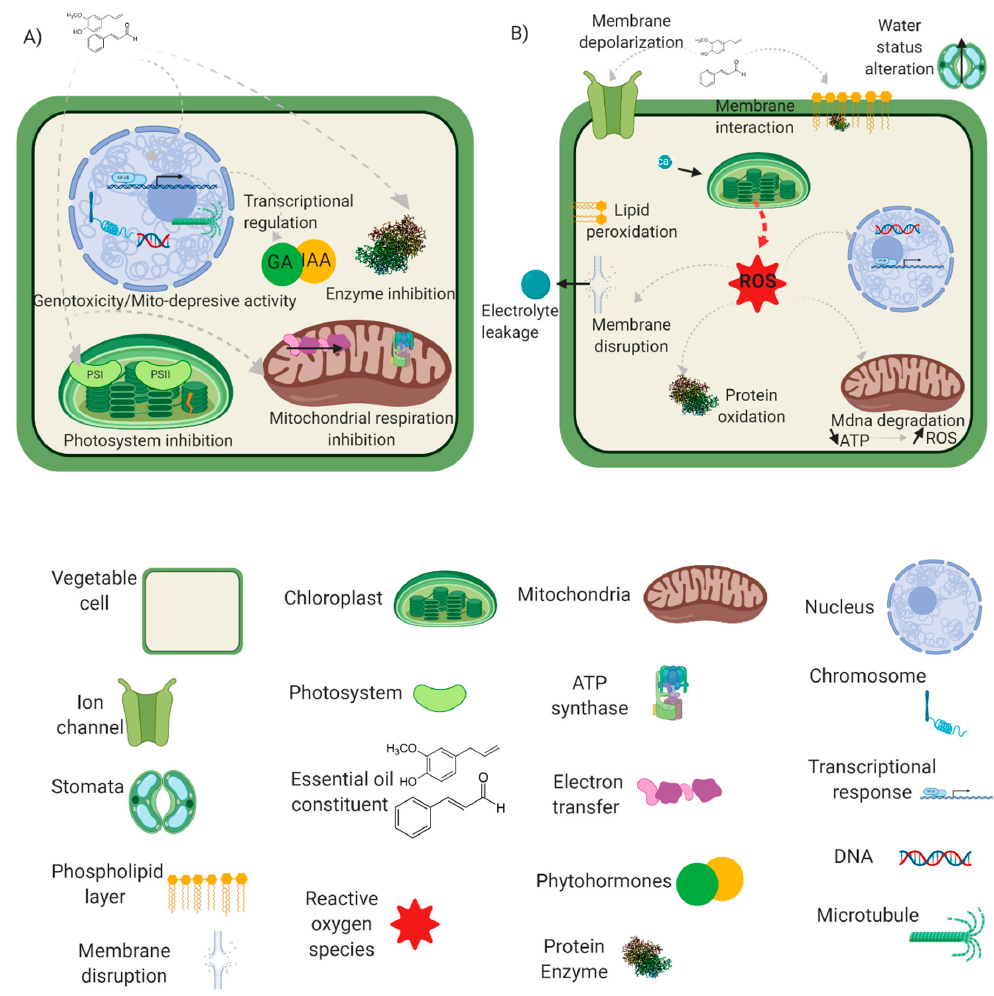
Figure 1. Mode of action of essential oil at the cellular level. ( A ) Photosynthesis and mitochondrial respiration inhibition, microtubule disruption and genotoxicity, enzymatic and phytohormone regulation. ( B ) Water status alteration, membrane properties and interactions, reactive oxygen species induction.